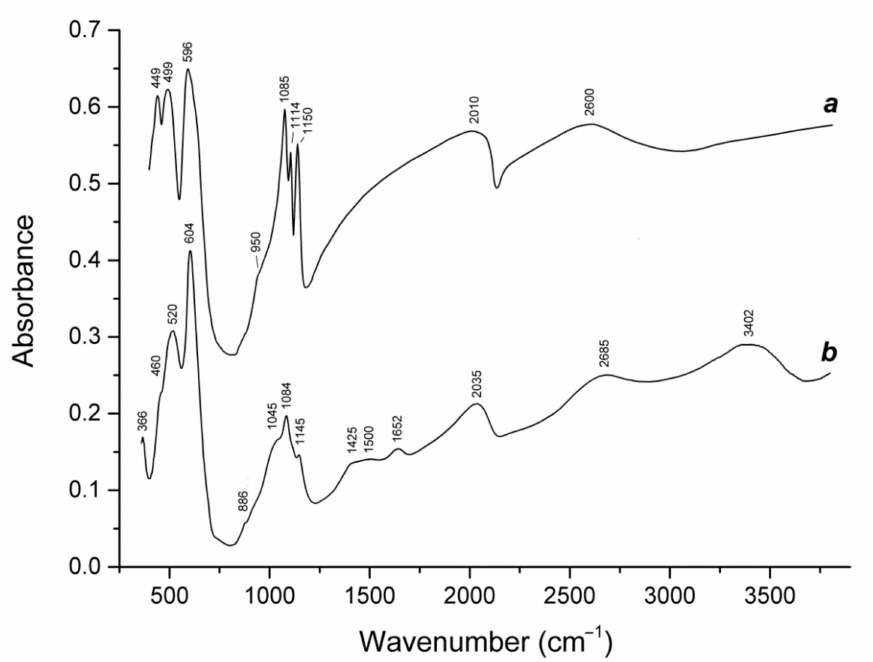
Figure 3. Infrared spectra of ( a ) manganite Mn 3+ O(OH) from Ilfeld, Germany, and ( b ) Zn-rich manganite-related mineral (Mn 3+ , Zn 2+ )O(OH,H 2 O) from Kapova Cave, Bashkortostan,